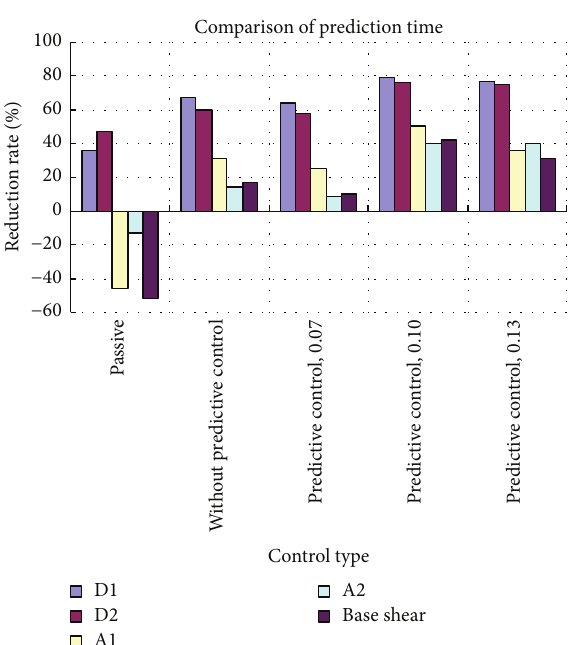
Figure 8: The average shock absorption ratios of the test structure with various control conditions under excitation of the El Centro earthquake.